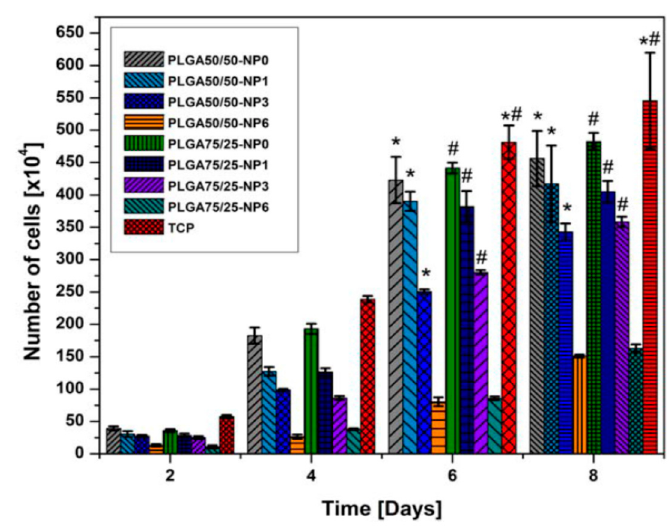
Figure 20. Proliferation of human dermal fibroblasts ( HDFs) determined by AlamarBlue test. * Significant against cell proliferation on PLGA 50/50–6%AgNPs scaffold at p ≤ 0.05; # Significant against cell proliferation on PLGA75/25–6%AgNPs scaffold at p ≤ 0.05 . NP: AgNPs. Reproduced with permission from [172], Copyright Wiley, 2015.